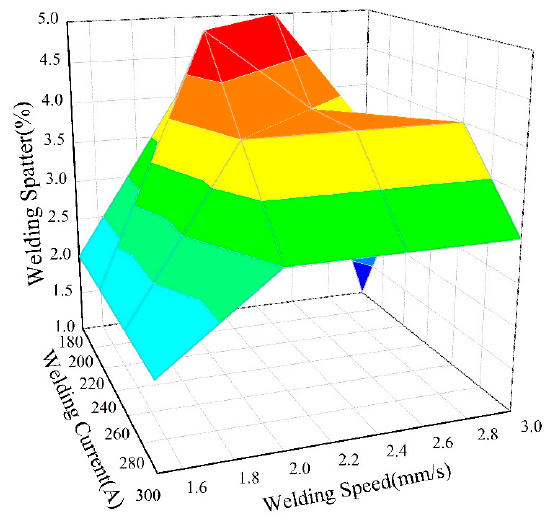
Figure 6. Interaction of welding speed and arc current on welding spatter.